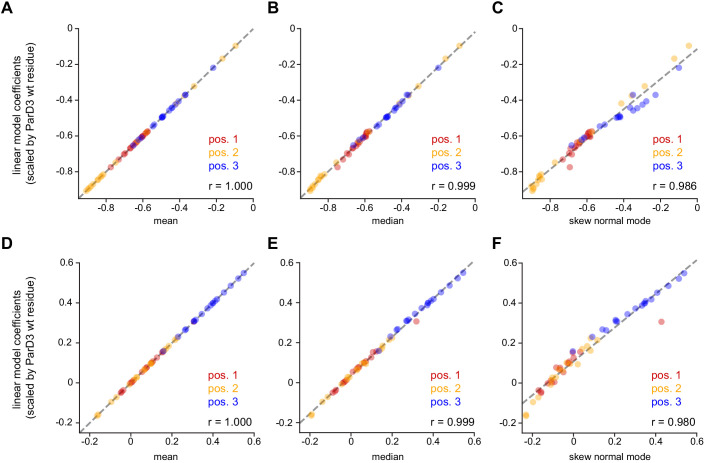
Comparison of linear model coefficients to parameters estimated from the distribution of fitness effects.Dashed line is regression line; Pearson r is indicated.